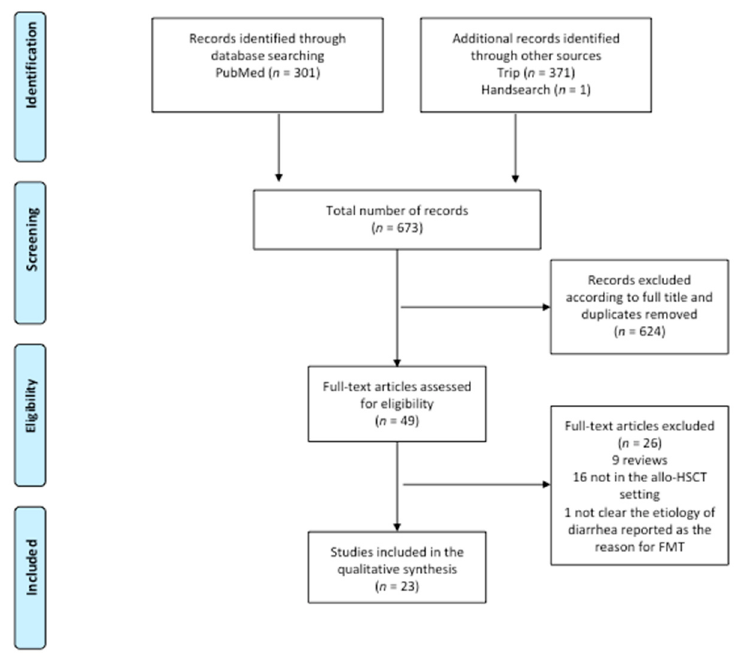
Figure 1. Preferred Reporting Items for Systematic Reviews and Meta-Analyses (PRISMA) flow diagram of the search strategy and included studies. The relevant number of papers at each point is given.